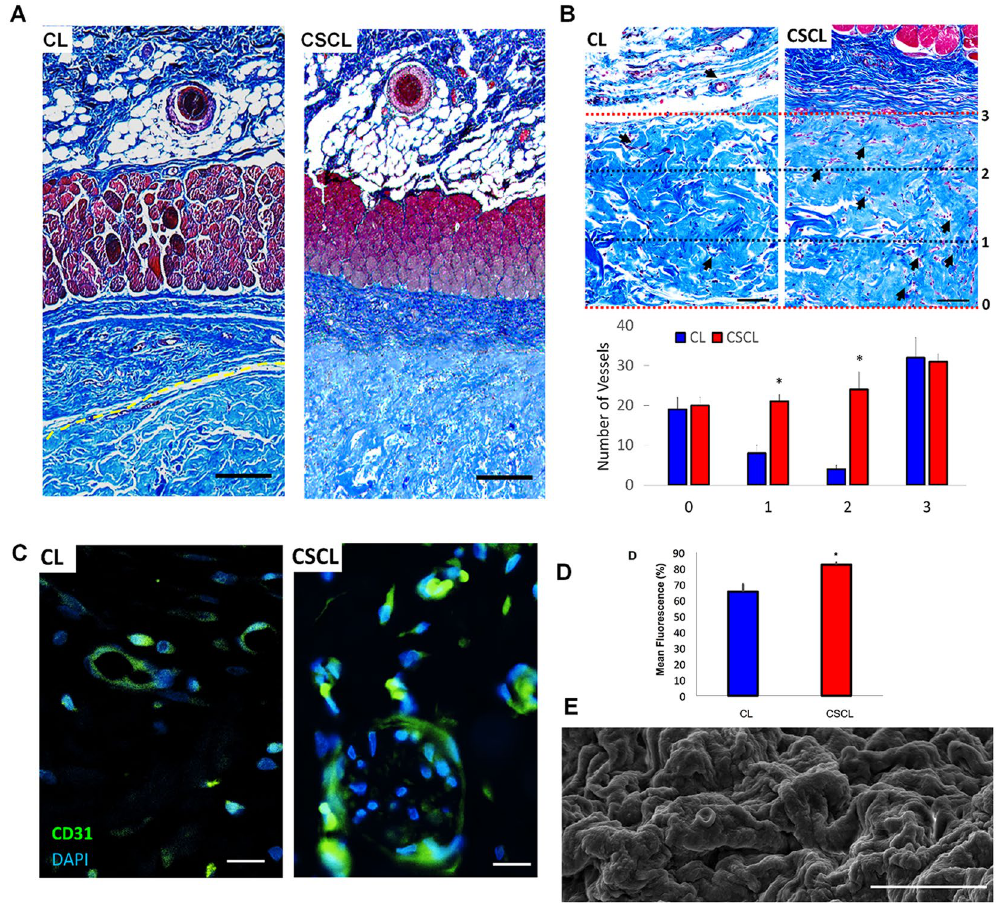
Figure 6. Scaffold integration. ( A ) Representative Masson’s trichromic stained whole section shows the different integration of the scaffold along all its cross-section between CL and CSCL (1 mm). ( B ) Representative Masson’s trichromic stained whole section shows the complete integration of the scaffold along all its cross- section (Scale bars: 100 μ m). Arrows indicate the vessels inside the scaffold. The graph indicates the presence of the vessels throughout the scaffolds’ thickness (distributed in the 3 areas) (n = 3, * p < 0.05). ( C ) Representative CD31 immunofluorescence stained section used for quantification (scale bars: 20 μ m). ( D ) Quantification of CD31 immunofluorescence stained section (n = 3, * p < 0.05). ( E ) SEM image of the scaffold surface shows completely remodeling of the scaffold (Scale bar: 10 μ